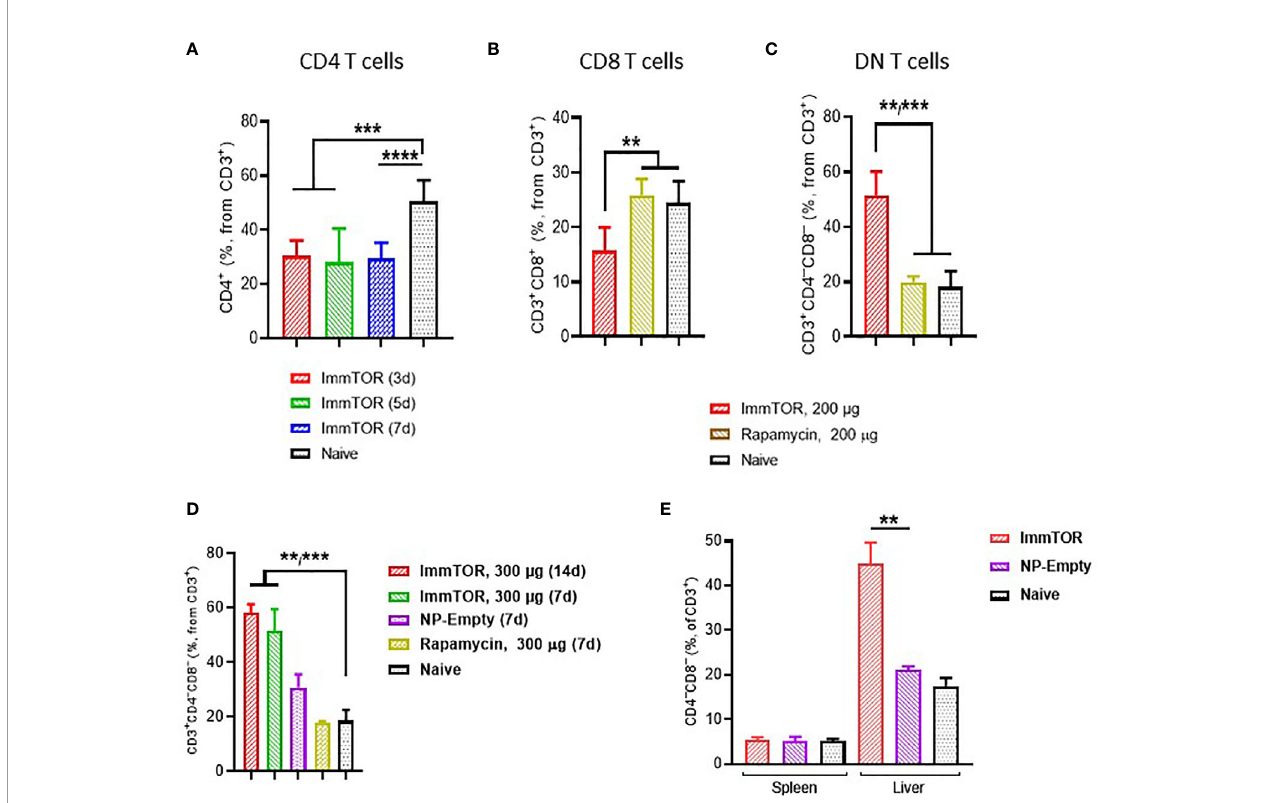
FIGURE 4 | ImmTOR treatment leads to the emergence of double-negative T cells in the liver but not spleen. Livers and/or spleen were processed and analyzed after i.v. injection of ImmTOR at 200 (A – C) or 300 µg (D, E) or the same dose of free rapamycin or empty nanoparticles (NP-Empty). Fractions of CD4 + (A) , CD8 + (B) and double-negative or CD4 – CD8 – (C, D) hepatic or hepatic and splenic (E) T cells (identi fi ed as CD3 + cells within lymphocyte gate) are shown. Timing of cell analysis is indicated in (A, D) analysis shown in other panels was done at either fi ve (E) or seven (B, C) days post injection. Summaries of three (A) or two (B, C) independent experiments are shown (n=5-13 or 4-8 mice/group, respectively), or representative results of individual studies (n=3-6 mice/group) repeated at least twice (D, E) . Data shown in A result from analysis of different and overlapping time-points. Statistical difference in the size of respective fractions at different time- points vs. that in naïve mice or mice injected with free rapamycin or NP-Empty is shown (** – p<0.01, *** – p<0.001, **** – p<0.0001; Mann-Whitney